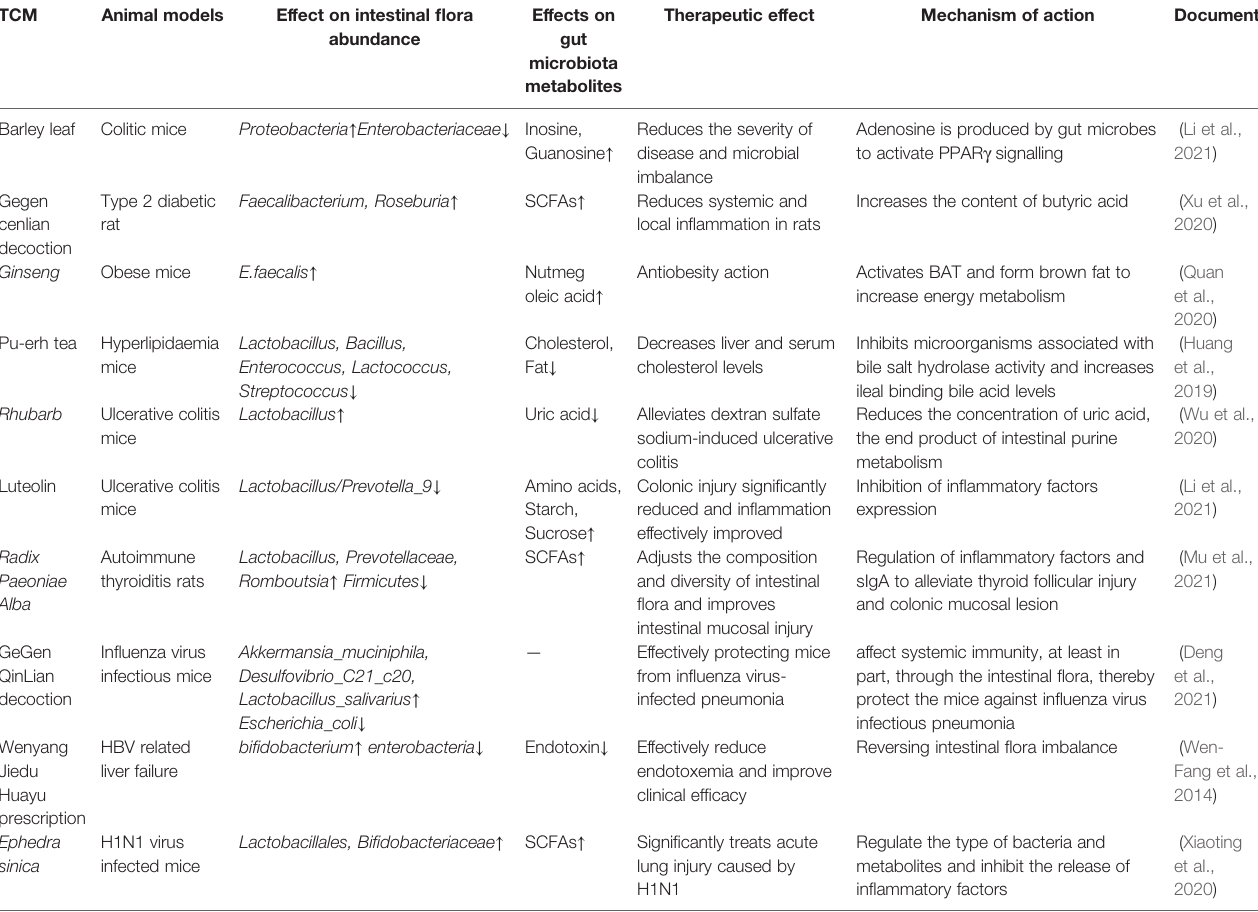
TABLE 1 | Regulation of intestinal fl ora and its metabolites by